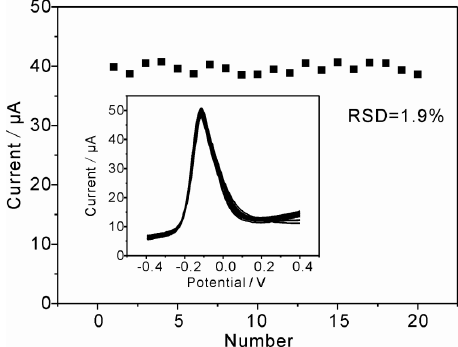
Figure 6. Repeatability measurements of 50 ppb As(III) on MnFe 2 O 4 /Au hybrid nanospheres modified GCE towards As(III) in 0.1 M HAc-NaAc (pH 5.0). Data are collected from every SWASV response shown in the inset. Experimental conditions are identical to those in Figure 4.